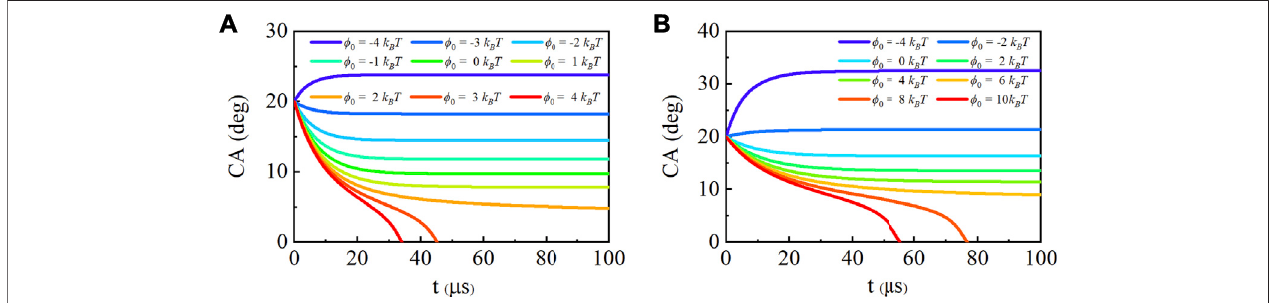
FIGURE4| Contactangle(CA)evolutionwithdifferentinteractionofthegasandsolid.Thefootprintradiusis L (cid:1) 100 nm,theinitialcontactangleis θ 0 (cid:1) 20 o andthe saturation ratio is (A) s (cid:1) 2.5, (B) s (cid:1) 3.